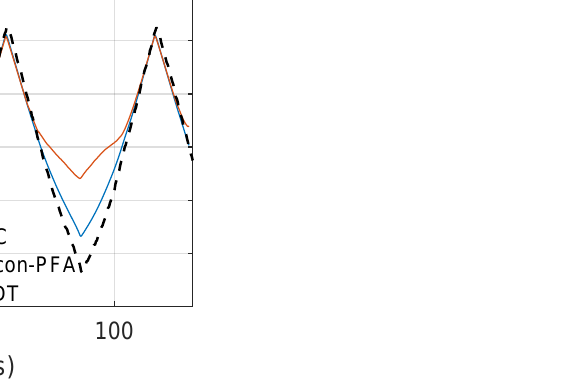
Figure 23. Comparison of fiber-optic and LVDT measurements of slot opening at a drift level of 0.95%.